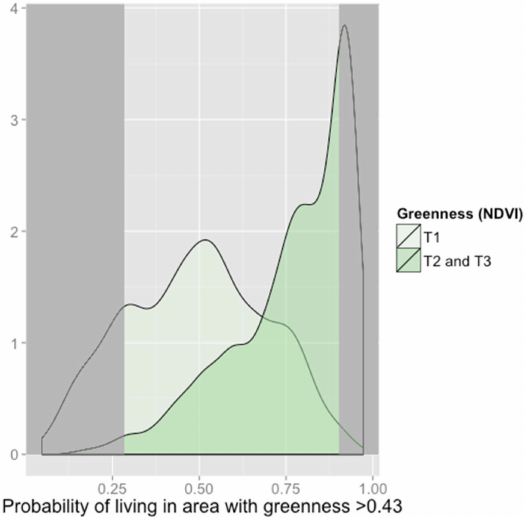
Figure 3. Propensity score distributions for patients in cities comparing those with NDVI values in the 2nd and 3rd tertiles (darker green) to the 1st (lighter green). The propensity score is the predicted probability of living in tertiles 2 or 3 (NDVI > 0.43), given baseline covariates. The analysis was restricted to participants with propensity scores outside of dark grey shaded regions to ensure that those living in green and non-green environments were